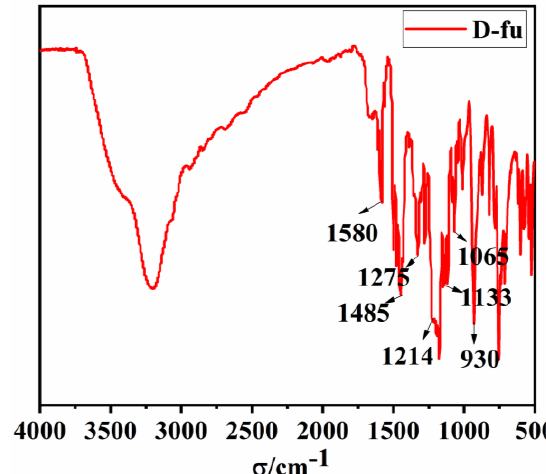
Figure 3. FITR spectrum of D−fu.